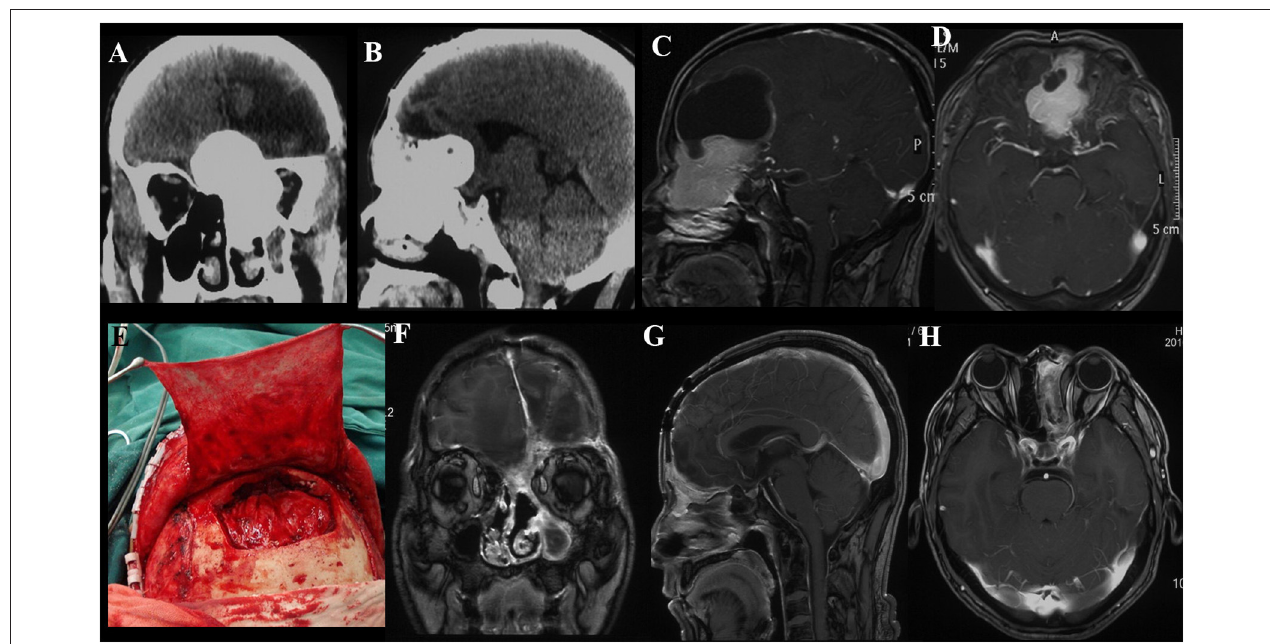
FIGURE 1 | Case illustrating the Derome approach. (A,B) CT scans show an anterior skull base tumor with nasal extension with significant calcifications. (C,D) T1-weighted sagittal and axial contrast-enhanced MRIs show the same tumor as A and B, the irregularly shaped lesion with heterogeneous enhancement and cystic changes. (E) A periosteal flap was prepared for repairing the skull base defect. (F–H) Postoperative contrast-enhanced MRIs indicated GTR of the